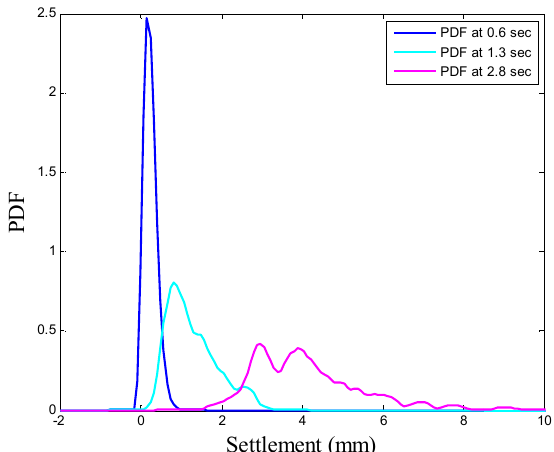
Figure 13. PDF of seismic settlement at three different time points.